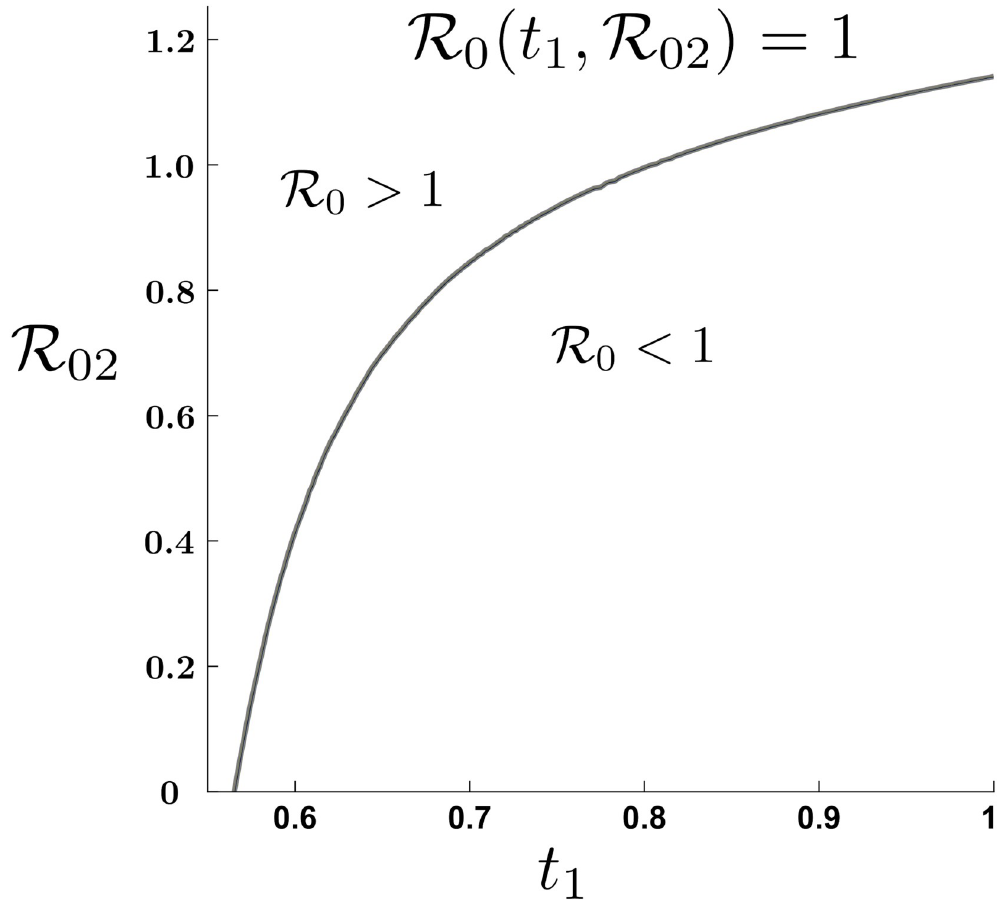
Fig 6. Global basic reproductive number level curve R eradicate a COVID-19 outbreak, ( R